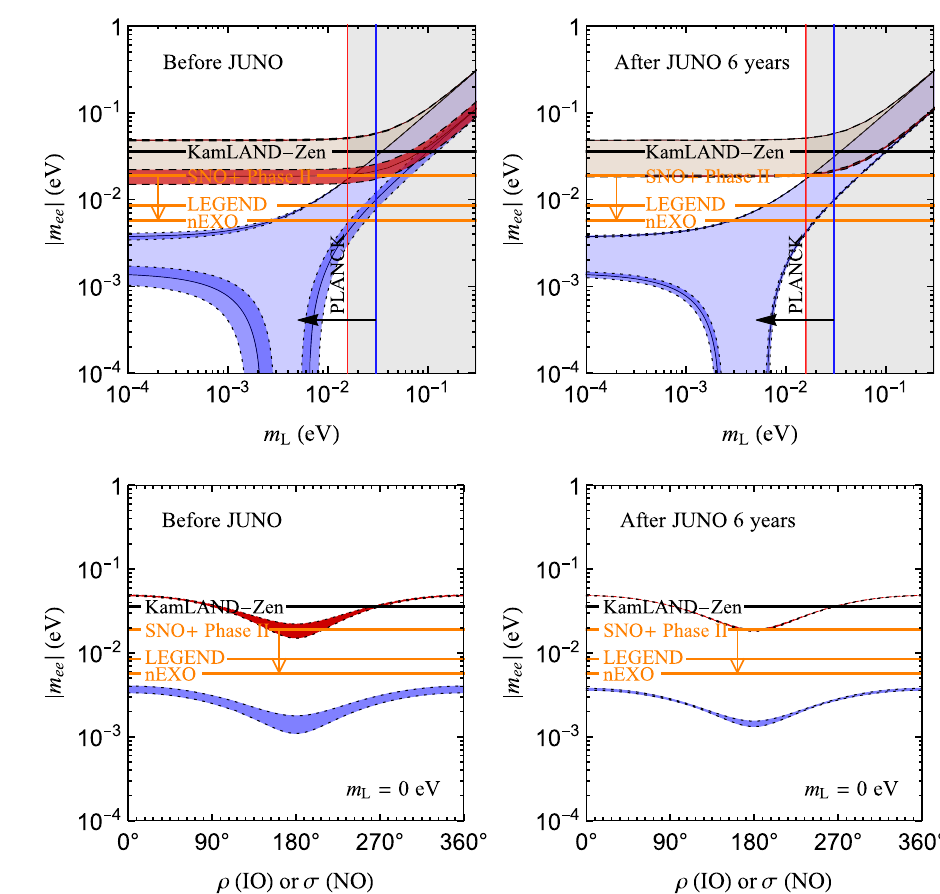
Fig. 1 The effective neutrino mass | m ee | as a function of the lightest neutrino mass (upper two panels) or the Majorana CP phase (lower two panels). The darker blue (for NO) and red (for IO) regions signify the 3 σ uncertainties ( χ 2 osc = 9) caused by neutrino oscillation parameters, i.e., θ , θ , Δ m 2 13 12 sol and Δ m 2 atm , and the lighter blue and red regions stem from the unknown Majorana CP phases ρ and σ . The left two panels are calculated by adopting the NuFIT5.1 global-fit results, while the right two panels give the prospects of 3 σ uncertainties after JUNO running for 6 years. For comparison, the KamLAND-Zen limit on | m ee | and projections of several future experiments (SNO+ Phase II [31], LEGEND [32] and nEXO [33]) at 90% confidence level (C. L.) are shown as the horizontal black and orange lines (with the most optimistic NME). For the lower two panels, the lightest neutrino mass m is L taken to be